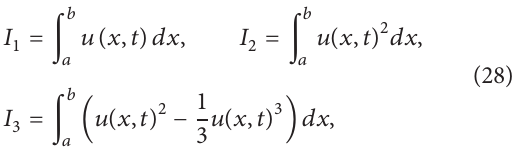
Table 1 indicates 𝐿 2 and 𝐿 ∞ errors and invariants with 𝑁 = 100 at time 𝑇 = 0.1, 0.2, . . . , 0.9 . The present method can also be shown to have the conservative